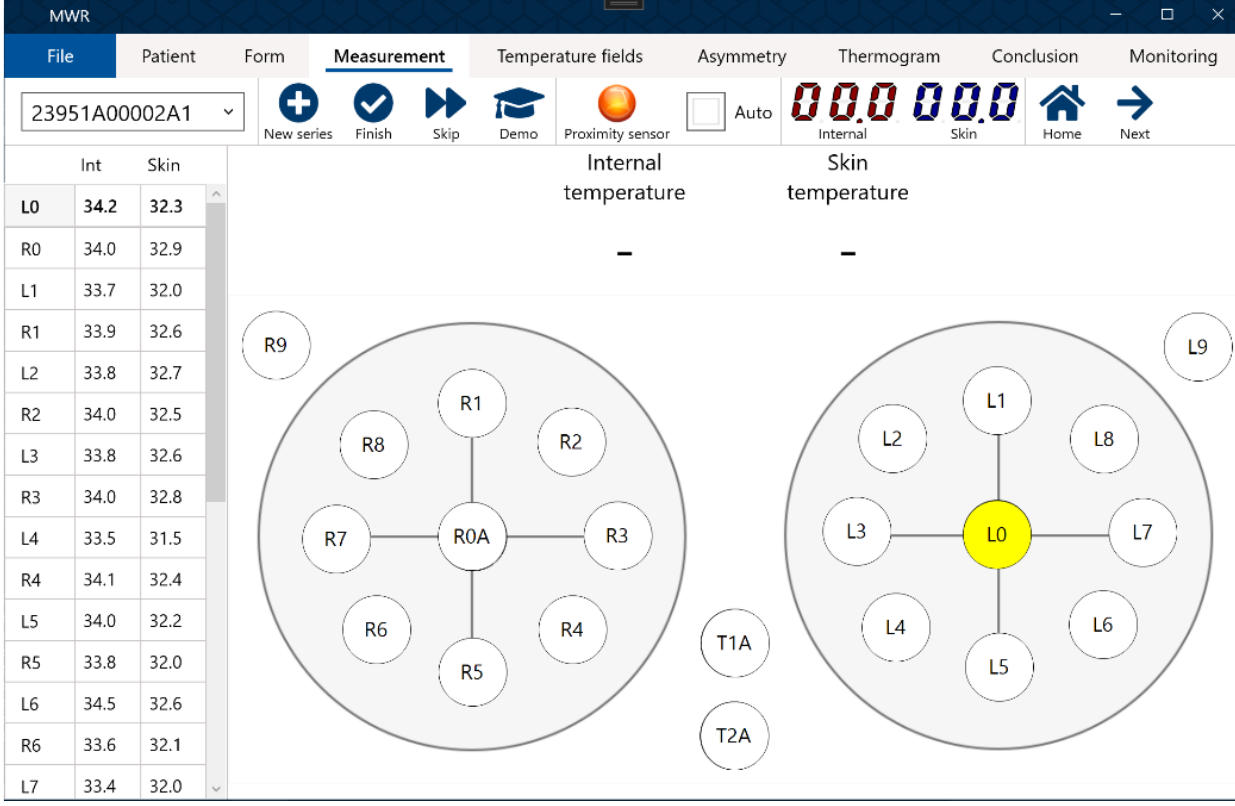
Figure 1. Interface of the MWR2020 software. Measurement points are shown. For further assessment, the temperatures were combined into groups: